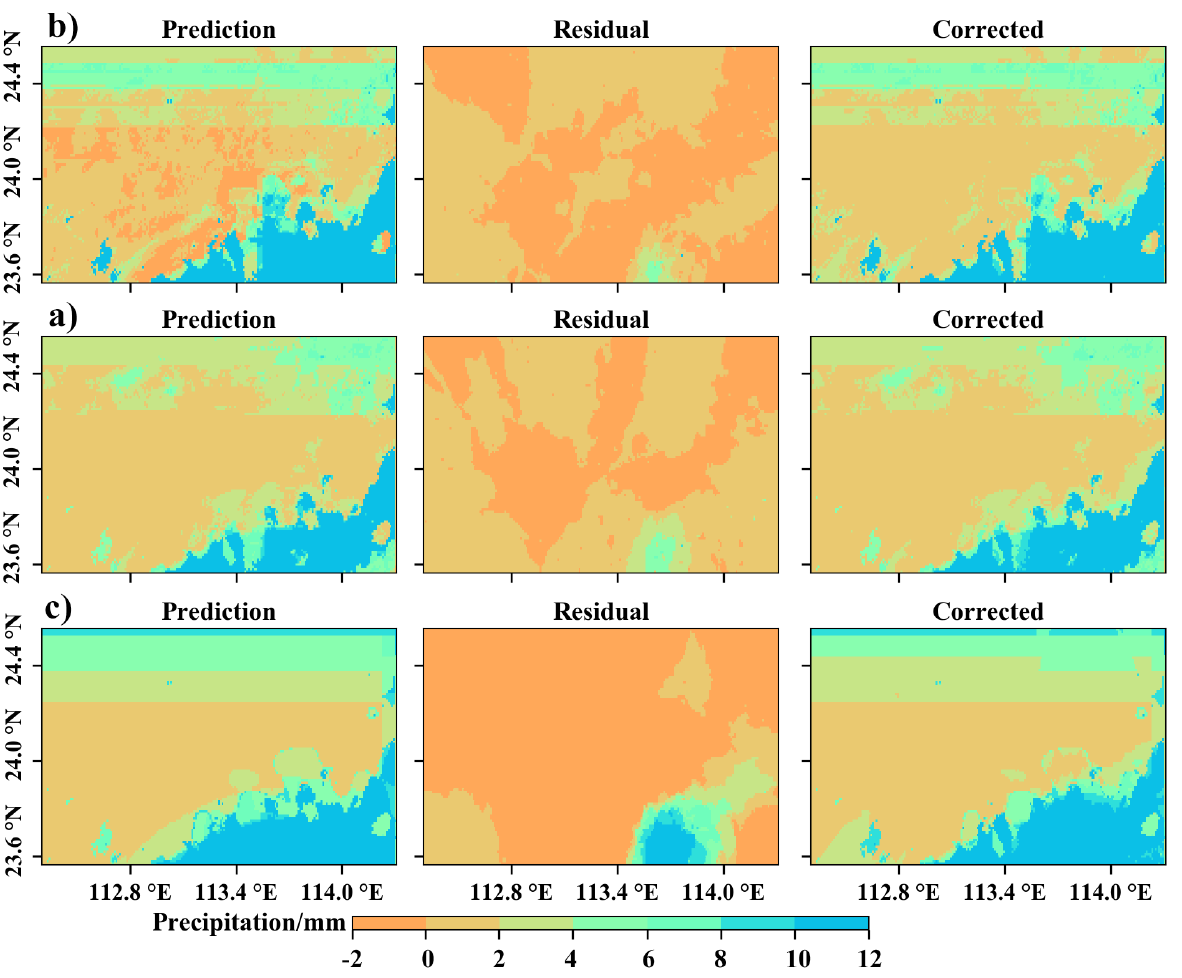
Figure 14. Residual correction for the results of the XGBoost, LightGBM, and RF methods at 9:00 on 7 May 2018: ( a ) XGBoost, ( b ) LightGBM, and ( c ) RF.